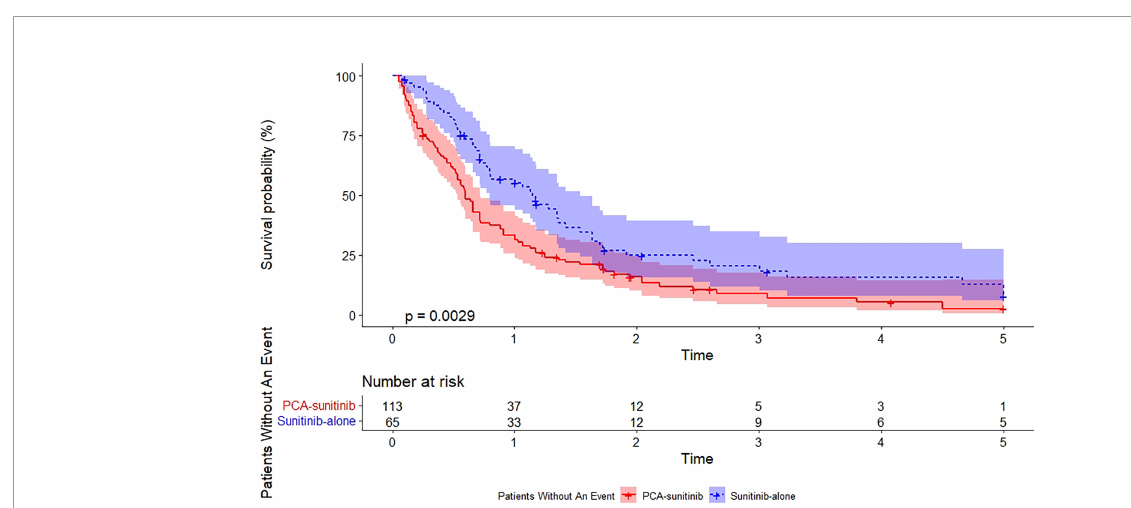
FIGURE 1 | Kaplan-Meier estimate of overall